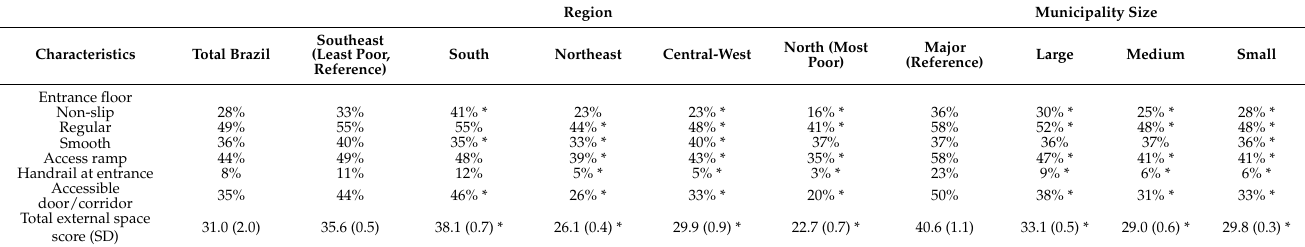
Table 3. Accessibility of external area of primary health care facilities, by Region of Brazil and Municipality